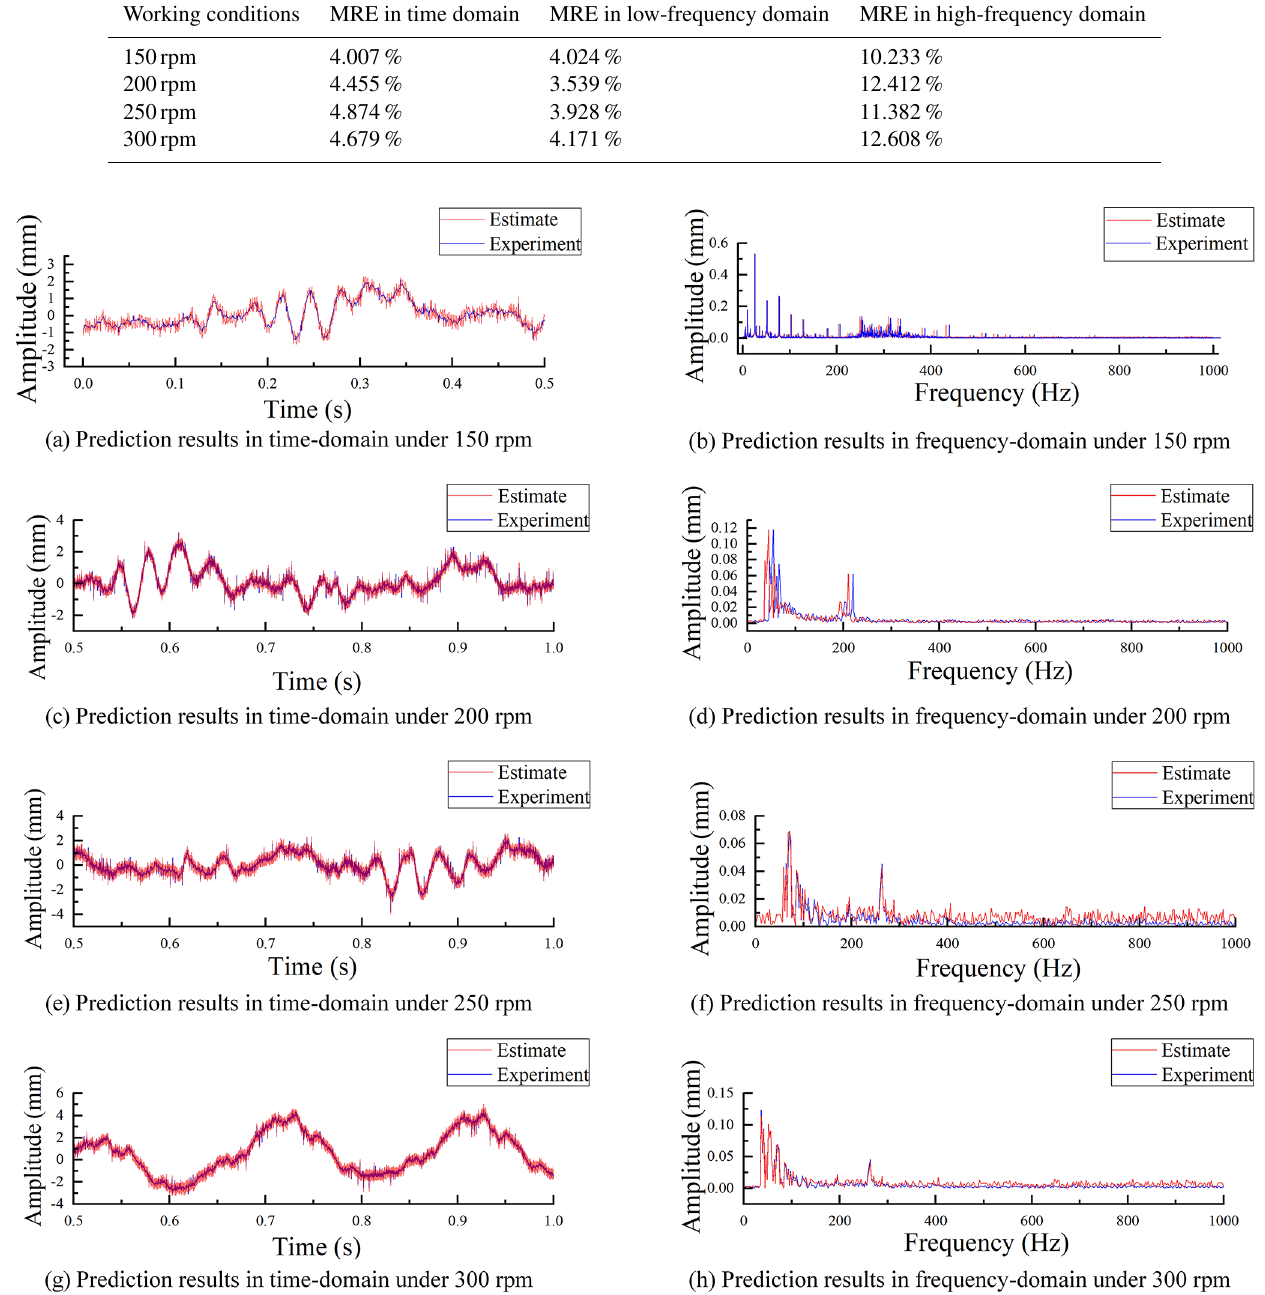
Figure 10. (a–h) Prediction results in time domain/frequency domain